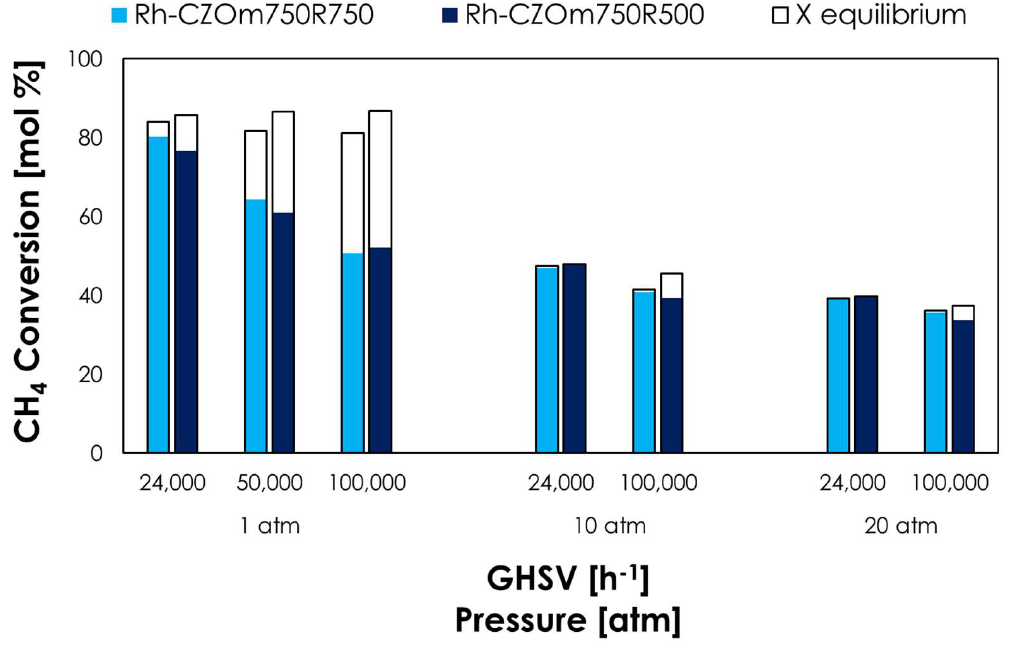
Figure 9. Methane conversion (colored bars) and equilibrium conversion (transparent bars) at 750 °C, S/C = 0.7, O/C = 0.2 and different pressures and GHSVs for Rh-CZOm750-R500 and Rh-CZOm750-R750.